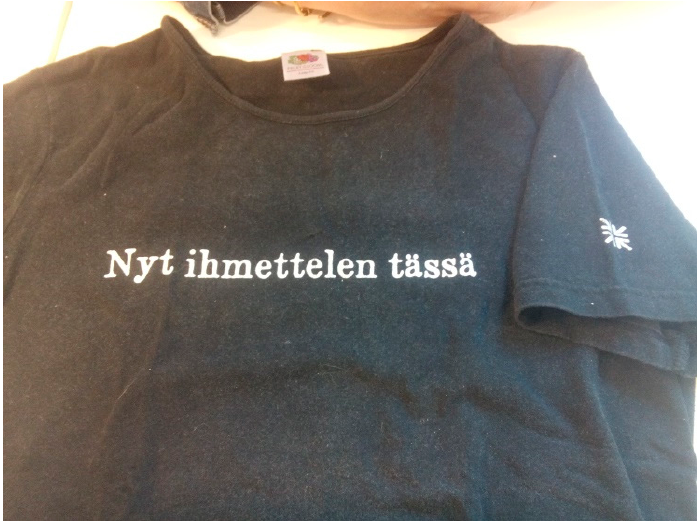
Figure 8. A körtti t-shirt, ‘Here I wonder’. The logo of Herättäjä-Yhdistys on the sleeve. Photograph: